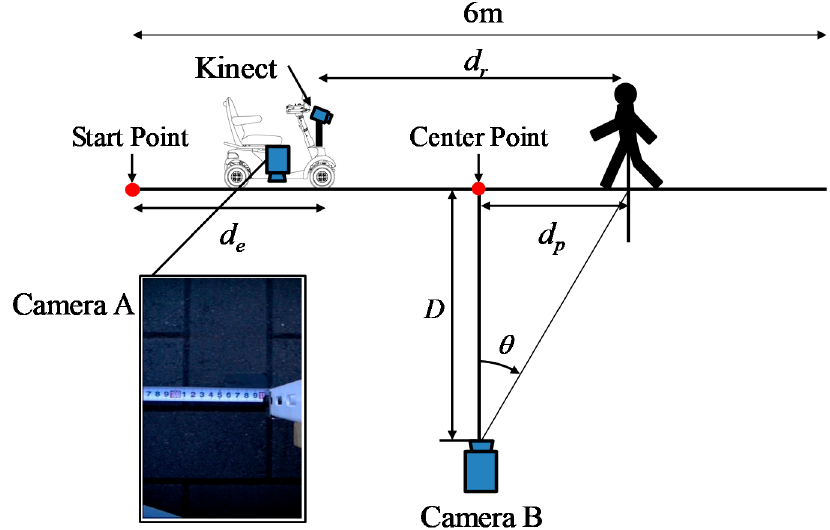
Figure 9. Method of acquiring the relative position of static and dynamic hazardous object from the electric wheelchair.